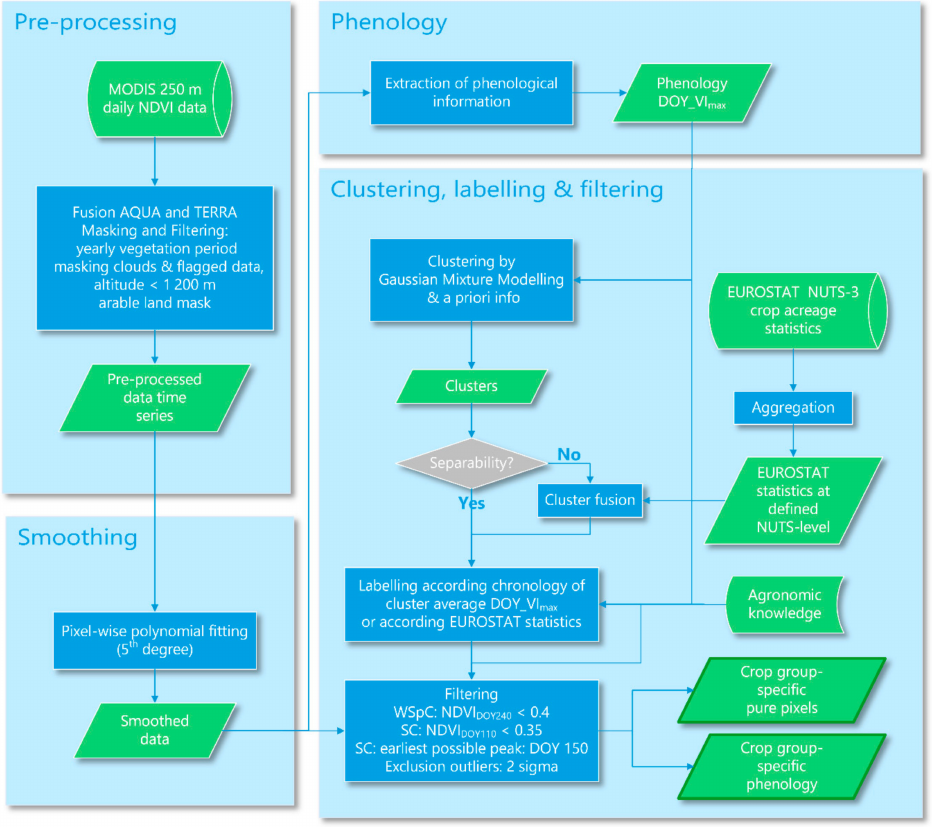
Figure 1. Flow diagram of pre-processing, phenology and noise removal, clustering, and labelling